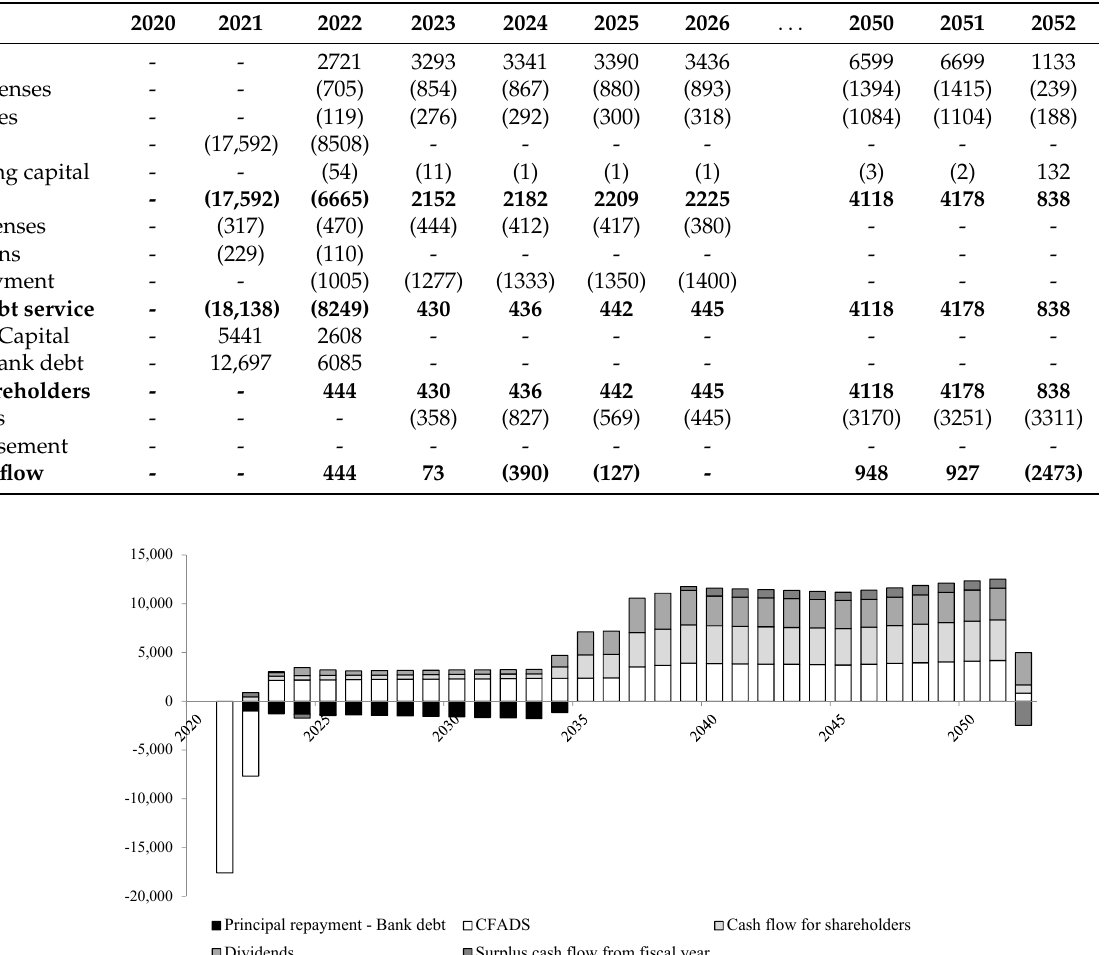
Table 5. Cash flow waterfall for the base case.